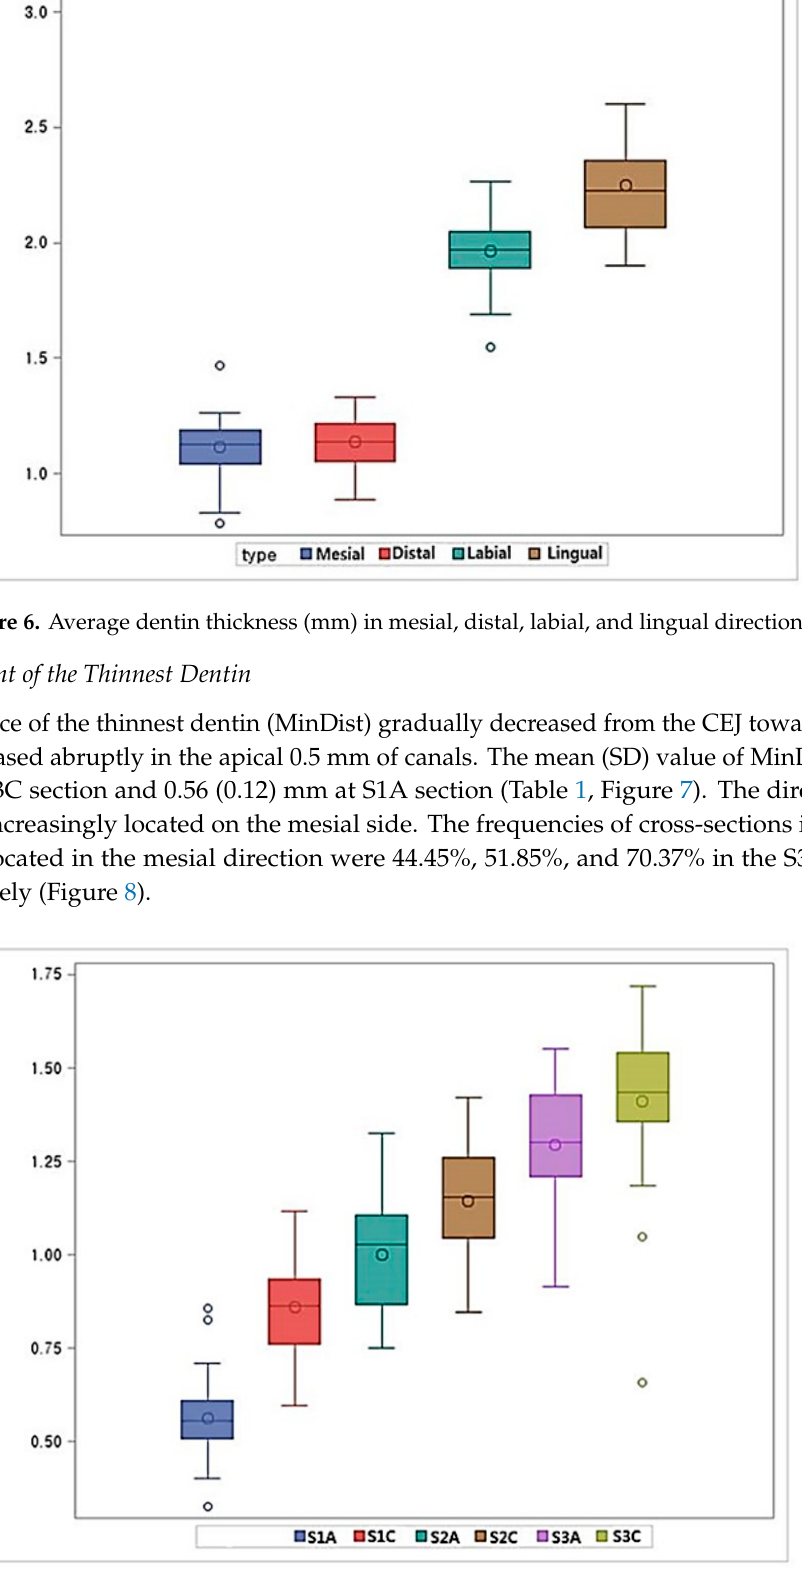
Figure 7. The thinnest dentin thickness (mm).